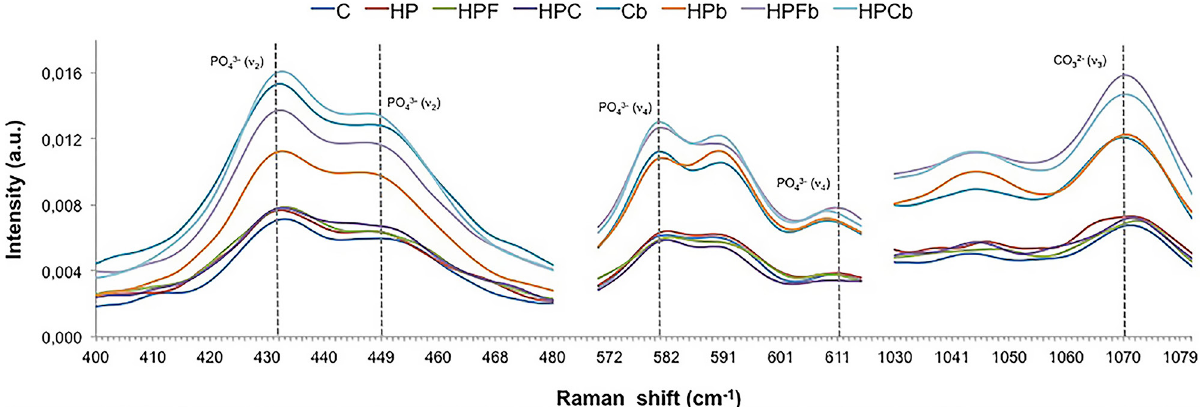
Figure 2- FT-Raman average spectra of mineral components in the 400-1.080cm -1 region showing phosphate peaks v 2 (431–449cm -1 and v 4, 582–611cm -1 ) and carbonate peak v 3 (1070 cm-1) of demineralized enamel before (C, HP, HPF and HPC) and after (Cb, HPb, HPFb and HPCb) bleaching. It can be noted that after bleaching, all groups tested increased phosphate ( v 2 and v 4) and carbonate ( v 3) inorganic contents of enamel